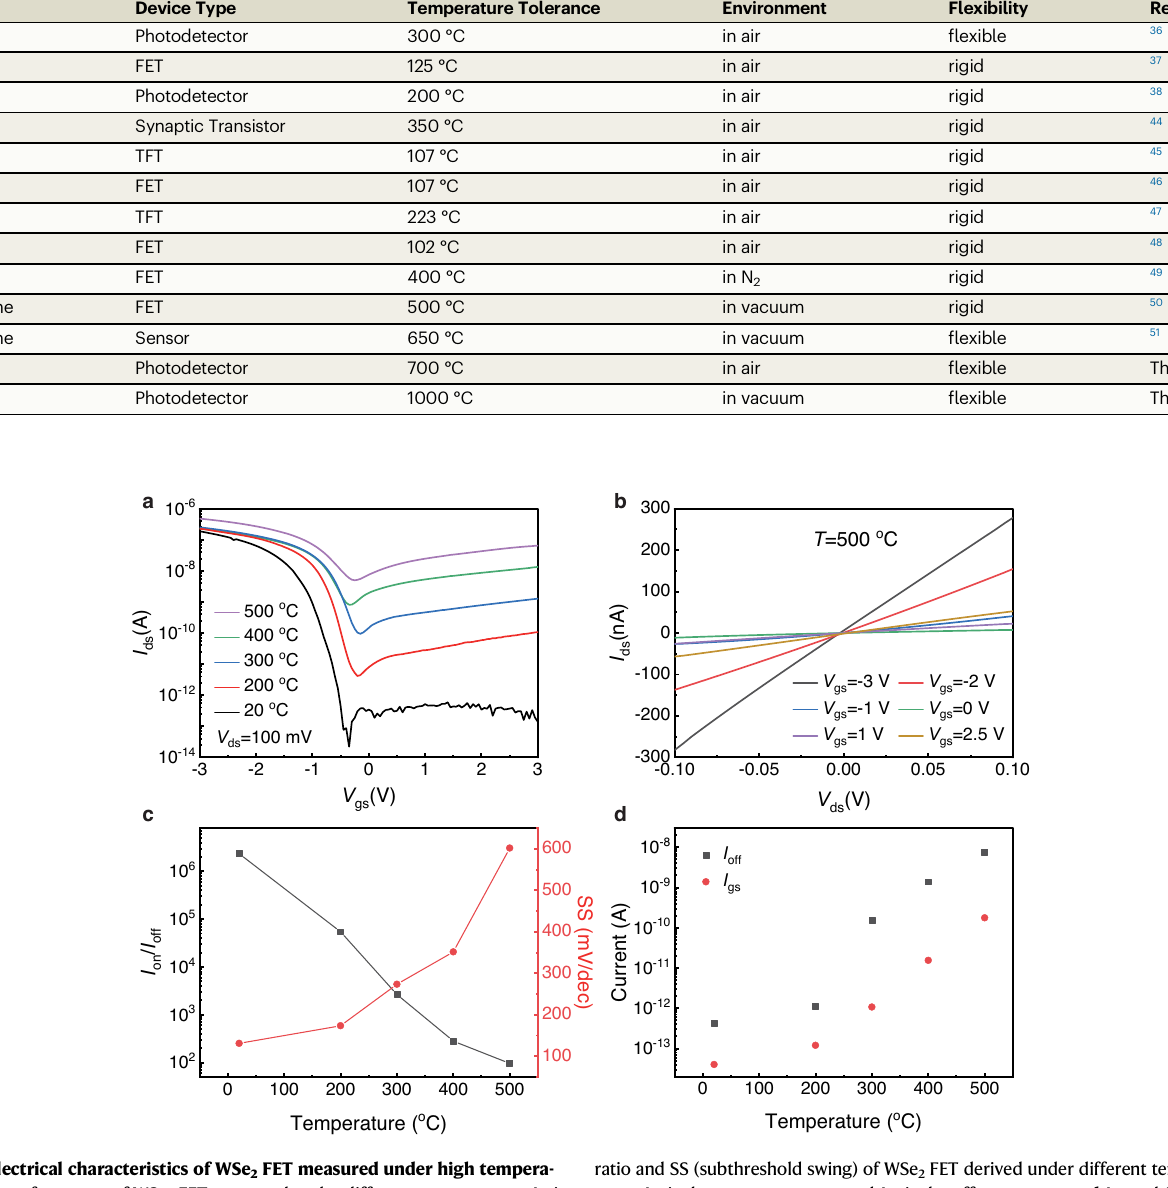
ratio and SS (subthreshold swing) of WSe 2 FET derived under different tempera- tures. I on is the on-state current and I off is the off-state current. d I off and I gs (h-BN leakage current) measured under different